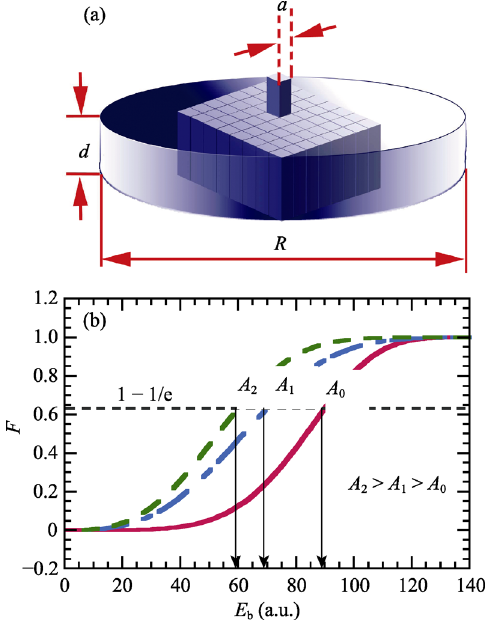
(a) Illustration of a ferroelectric film with a thickness ( d ) and diameter ( R ) divided into small square columns with an edge length of a for defect dielectric breakdown model analysis. (b) Weibull cumulative distribution function of the effect of electrode area on the average dielectric breakdown electric field ( E A